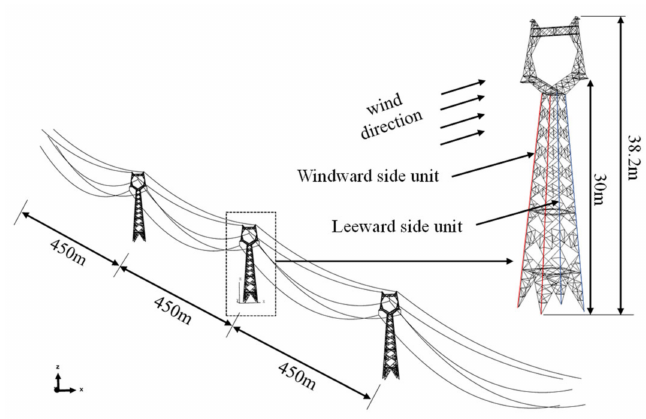
Figure 13. FEM model of tower-line